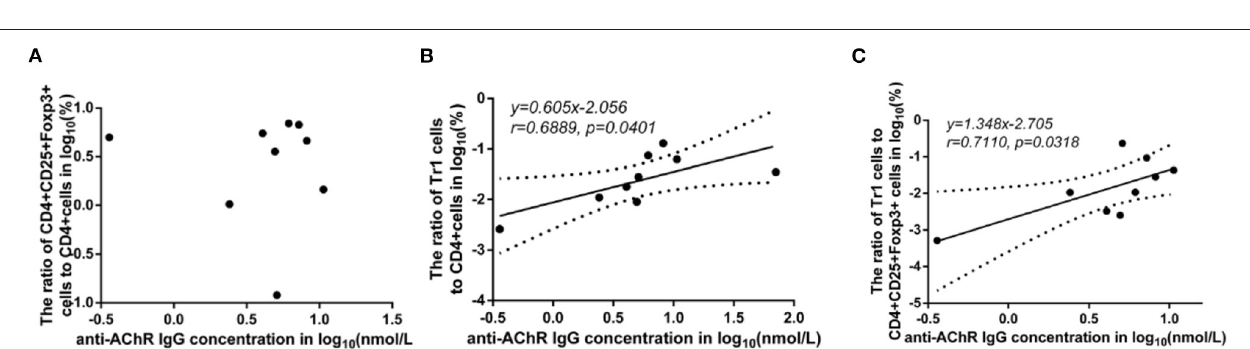
FIGURE 6 | Association between the anti-AChR Ab levels and the ratios of Treg subgroups in MG patients. Shapiro-Wilk’s tests were used to assess normal distribution of the data. We identified one outlier using outlier boxplot tool, and this outlier was omitted from graphical presentation of the data, with no effects on the statistical results. Linear regressions (solid black lines) with 95% CI (dotted lines) were conducted to analyze the relationship between the anti-AChR Ab levels and the ratios of Treg subgroups in MG patients, and slopes were compared to 0 in addition to Spearman’s correlation test in order to access correlations between variables. (A) , no significant correlation between anti-AChR Ab concentration and FoxP3 + Treg/CD4 + T ratio. (B) , a positive correlation with statistically significant was found between Tr1/CD4 + T cell ratio and the level of anti-AChR Ab ( r = 0.6889 ± 0.4414, p = 0.0401). (C) , a positive correlation with statistically significant was discovered between Tr1/FoxP3 + Tregs cell ratio and the level of anti-AChR Ab ( r = 0.7110 ± 0.4227, p = 0.0318). N = 9 for MG patients (one outlier was omitted).